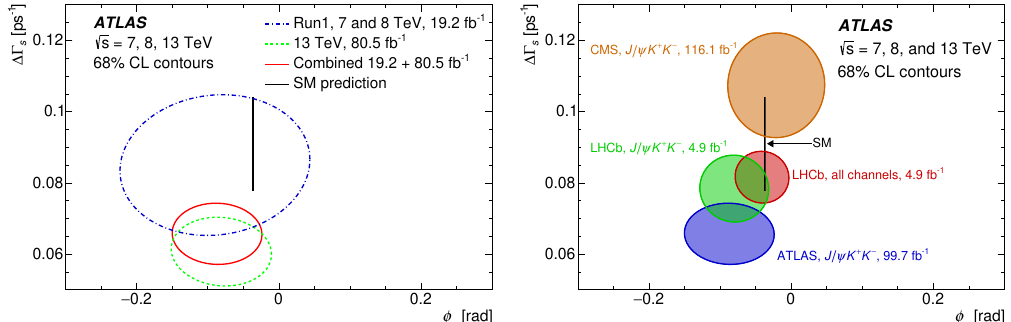
− ∆Γ plane [ 8 ] . (Left) s s